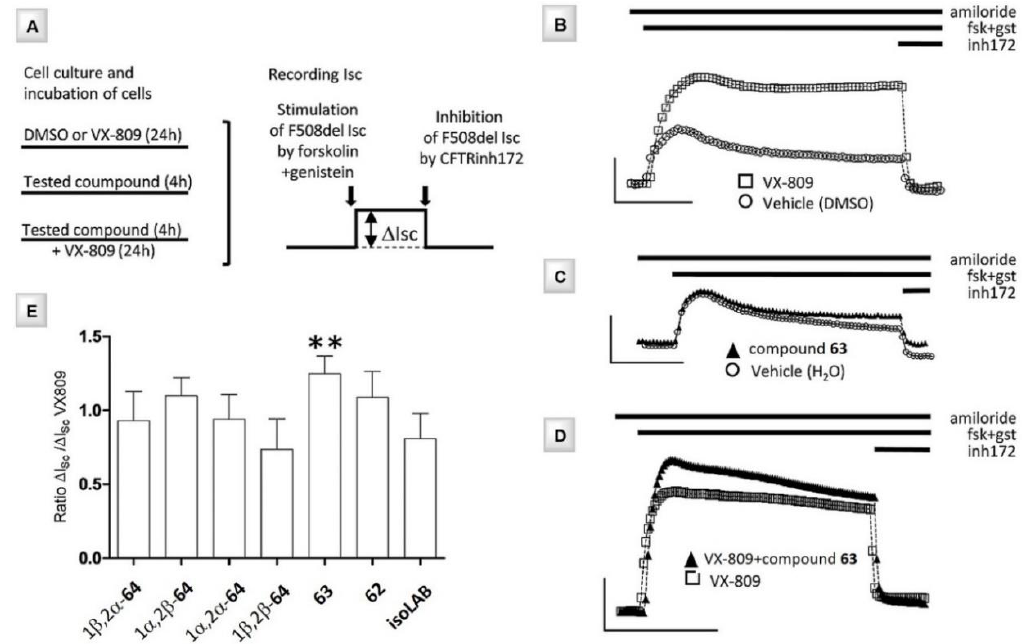
Figure 13. Transepithelial short-circuit currents (Isc) recorded in F508del-CFTR-expressing CFBE ( A ) Protocols used and model trace indicating ∆ Isc. ( B – D ) Tracings of Isc recorded with CFBE cells cells. ( A ) Protocols used and model trace indicating ΔIsc. ( B – D ) Tracings of Isc recorded with CFBE incubated with: ( B ) DMSO or VX-809 (10 µ M) (24 h); ( C ) water or 63 (100 µ M) (4 h); ( D ) VX-809 (10 µ cells incubated with: ( B ) DMSO or VX-809 (10 μM) (24 h); ( C ) water or 63 (100 μM) (4 h); ( D ) VX-809 (10 μM, 24 h) or VX-809+ 63 (100 μM, 4 h). F508del-CFTR was activated by application of CTR